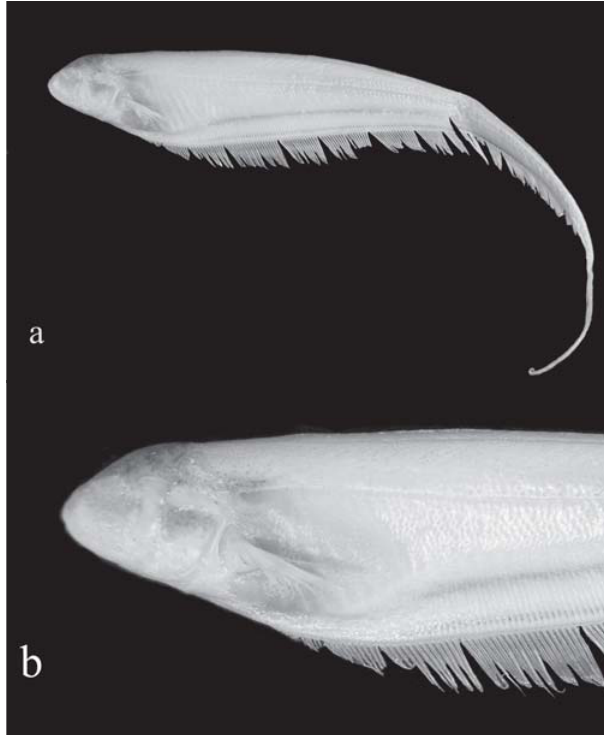
Fig. 5. Preserved specimen of Eigenmannia vicentespelaea with no visible eyes and pale aspect (LEA: 67.6 mm). a . Entire individual. Scale bar, 10 mm; b . Detail of head with no visible eyes. Scale bar, 5 mm. Photos: M. E. Bichuette.